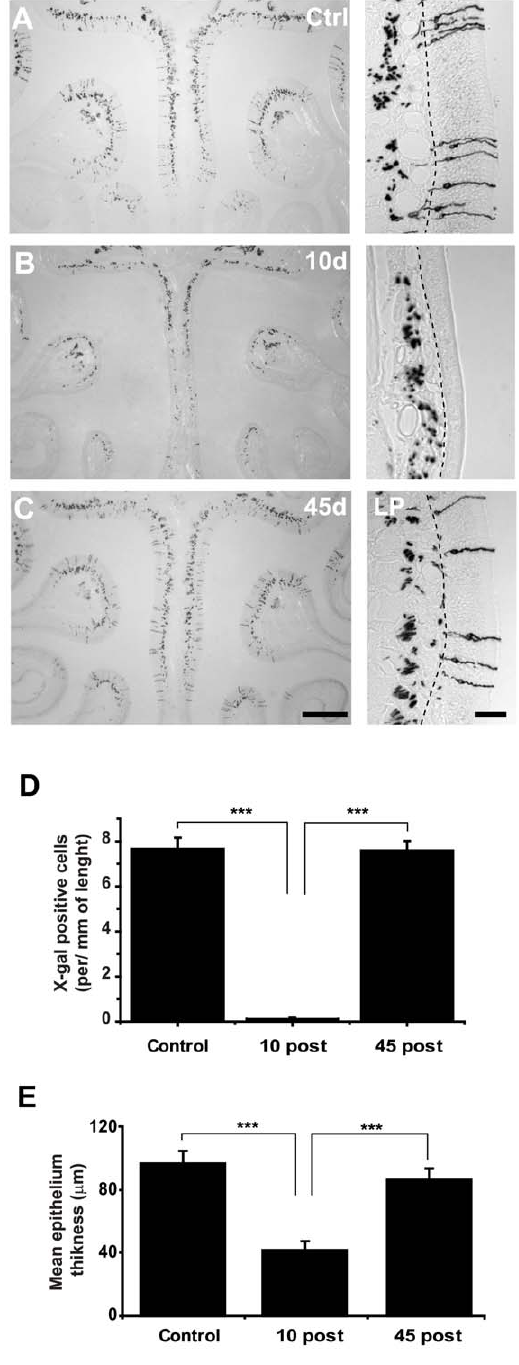
Figure 2. M72-expressing OSN population is regenerated 45 days after methimazole treatment. A , Coronal view of control olfactory epithelium is shown. At higher magnification X-gal stained neurons can be observed within the OE and axons can also be seen traversing the LP. B , Almost no X-gal stained neurons can be observed 10 days post lesion. Some axons bundles remain visible along the LP. C , 45 days after methimazole induced lesion, the regenerated olfactory epithelium cannot be distinguished from that of control animals. D , Cell counts in the OE show that the population of M72 neurons is regenerated after methimazole treatment. E , Thickness of olfactory epithelia is significantly decreased 10 days post lesion. Mean 6 SEM. Scale bars 400 m m and 80 m m in OE magnifications. *** denotes P ,